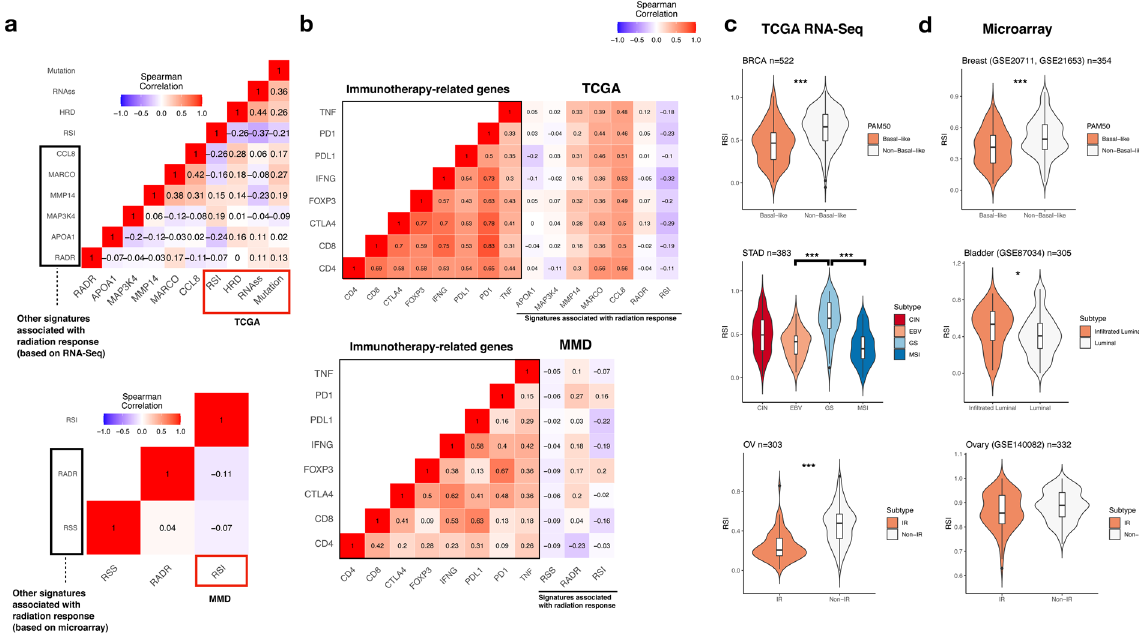
Fig. 1 Association of RSI and other gene signatures with immune-related phenotypes and molecular features. a Matrix heatmap of Spearman ’ s correlation among RSI, RADR, RSS, APOA1 , MAP3K4 , MARCO , CCL8 , HRD, RNAss, and TMB in TCGA (upper panel) and MMD (lower panel). Colour bar indicates Spearman ’ s rho. b Matrix heatmap of Spearman correlation with immunotherapy-related genes ( TNF , PD1 , PDL1 , IFNG , FOXP3 , CTLA4 , CD8 , and CD4 ) in TCGA (upper panel) and MMD (lower panel). Colour bar indicates Spearman ’ s rho. c Association of RSI with molecular subtypes in cancer of the BLCA, BRCA, OV, and STAD in TCGA. d Association of RSI with molecular subtypes in cancer of the bladder, breast, ovary, and stomach in MMD. The black horizontal lines represent the median. CIN: chromosomal instability; EBV: Epstein – Barr virus (EBV)-associated; GS: genomically stable; MSI: microsatellite instability; IR: immunoreactive. Mann – Whitney U-test *** p < 0.001, ** p < 0.01, * p <